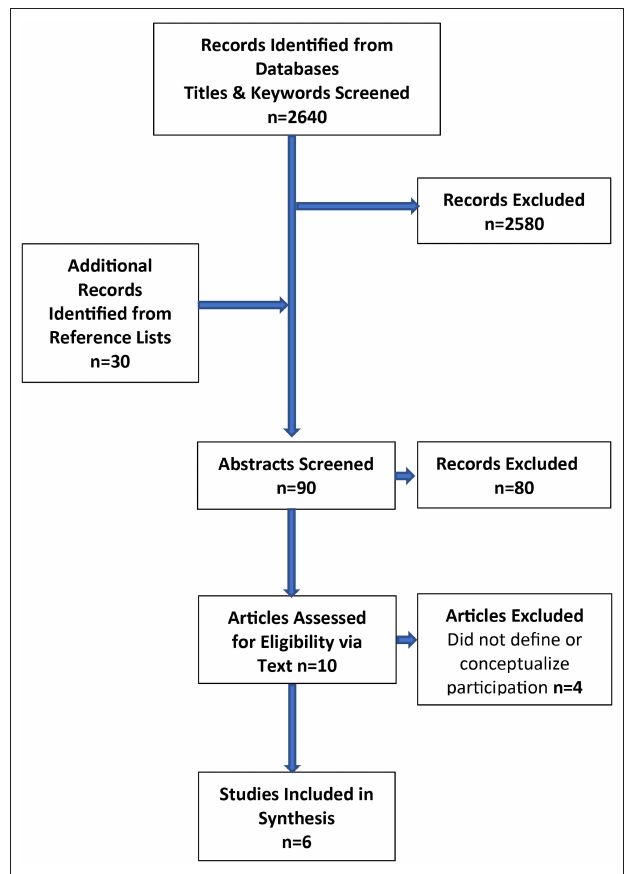
FIGURE 1 | Flow chart of article selection